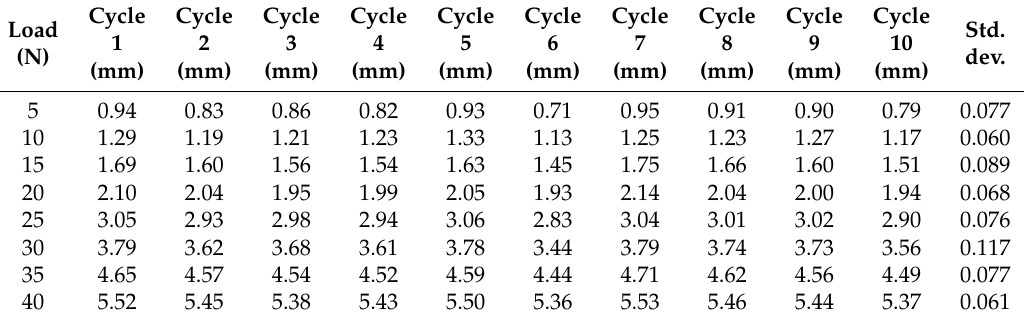
Figure 21. Experiment results: force vs. structure deflection for sensor structure (only) using the force indenter during one testing cycle. Table 2. Force and structure deflection values for the sensor structure (only) during ten consecutive